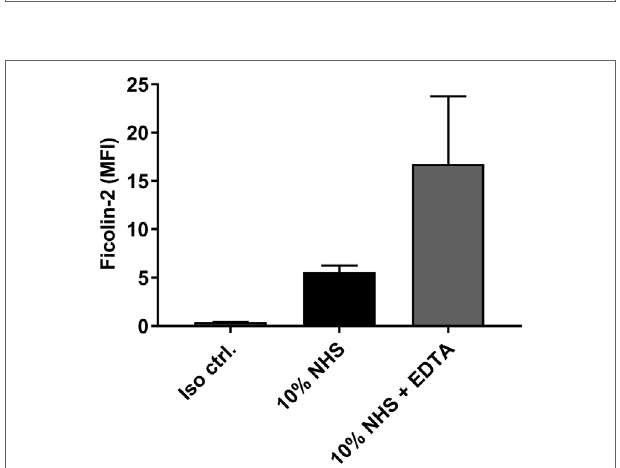
FigUre 3 | Western blot detection of bound serum ficolin-2 to isolate C322-17. Isolates C322-17 (high binding), E3-1065539 (low binding), and H57553 (low binding) was incubated with 10% normal human serum and the eluates were separated by SDS PAGE and detected by western blot. 0.25 µg rficolin-2 was added as a positive control and specific mAb was used to detect